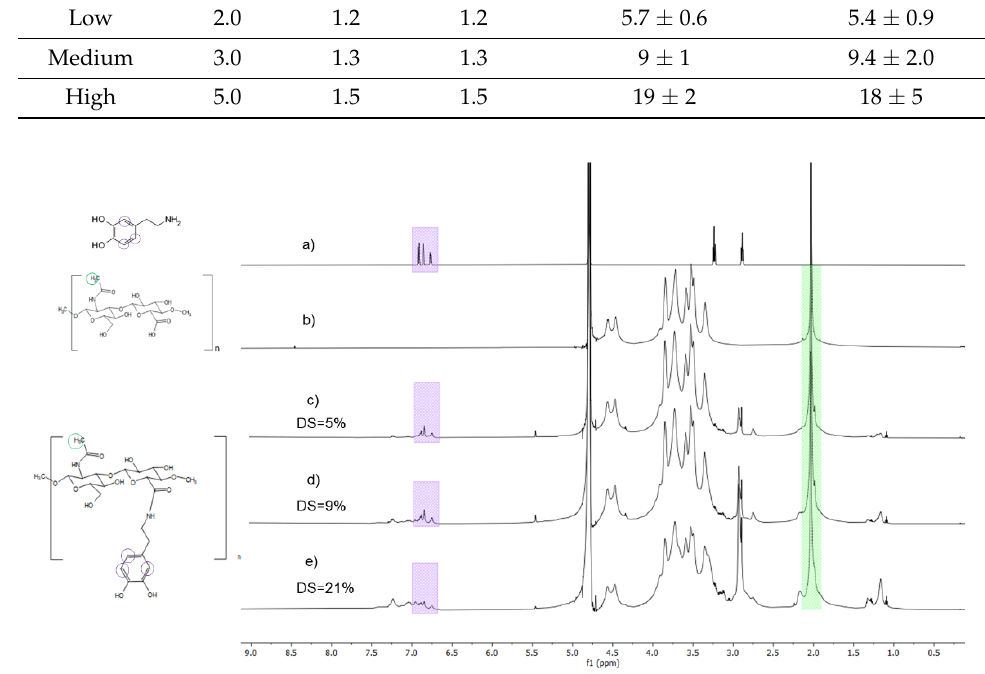
Figure 1. 1 H-NMR spectra of ( a ) dopamine, ( b ) hyaluronic acid (HA), ( c – e ) HA-dop with different DS (acetyl peak outlined in green, dopamine in purple). Table 1. Molar equivalents of the reactants relative to HA carboxyl and mean DS obtained over n = 3 batches of HA-Dop synthesis ( n = 3).